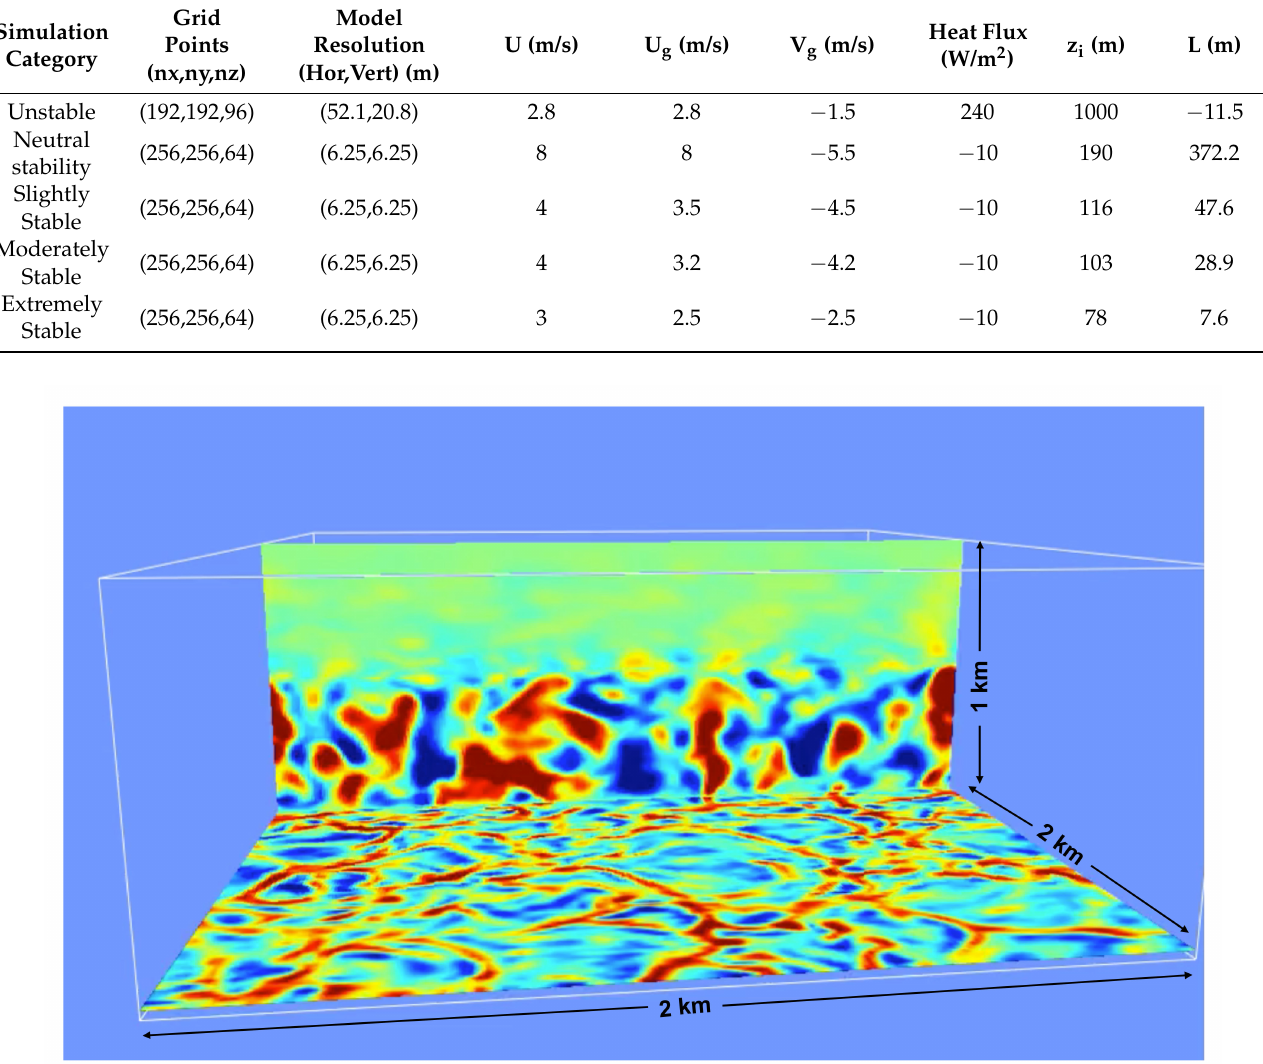
Table 3. The JOULES GPU-LES model configuration parameters.